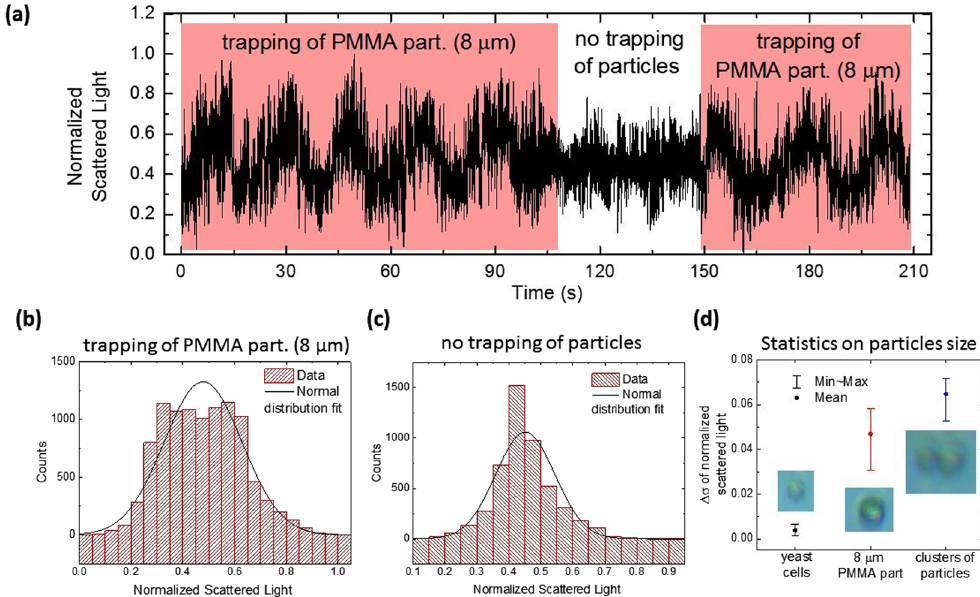
Figure 13. ( a ) Measurement of the light scattered by an 8 μ m PMMA bead, and during the absence of trapping. ( b ) Normal distribution fit correspondent to the first trapping event shown in ( a ). ( c ) Normal distribution fit of the data representative of the absence of trapped particles. ( d ) Study of Δσ for yeast cells, 8 μ m PMMA beads and clusters of particles. The images inside the graph are examples of the targets (scale